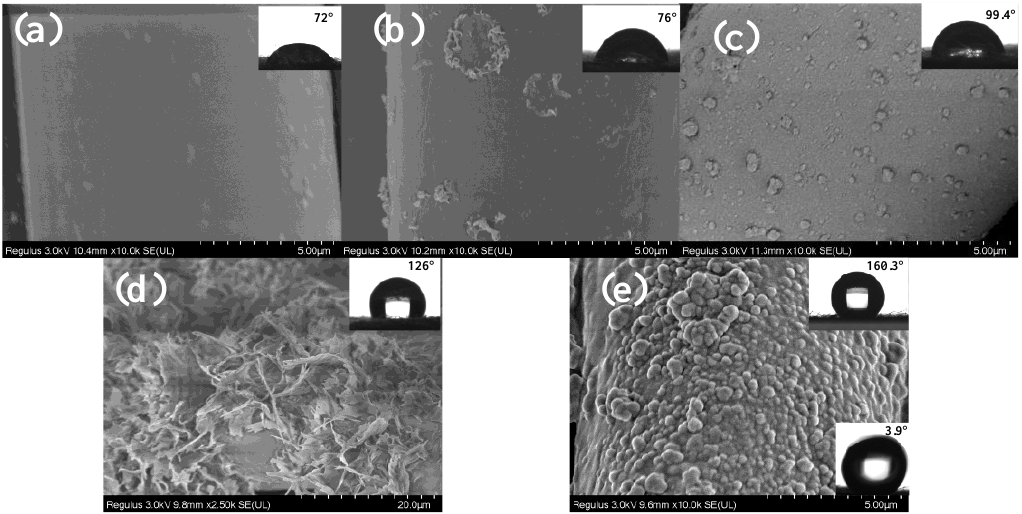
Figure 3. SEM photos of polyester fabric. ( a ) PET; ( b ) CA-PET; ( c ) CA-Fe-PET; ( d ) SH-PET; ( e ) CA-Fe-SH-PET.